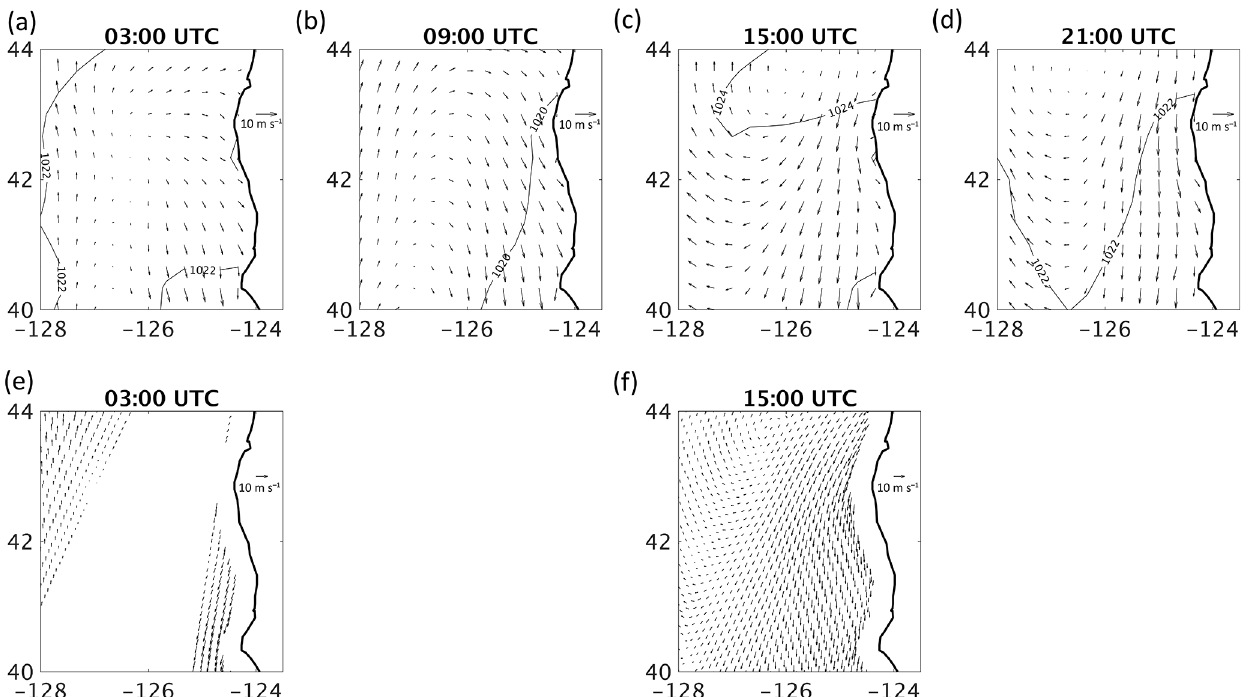
Figure 8. Data stage inputs for the surface wind BHM in the CCS. Analysis fields for surface wind (vectors) and sea-level pressure contours (hPa) from COAMPS for (a) 03:00, (b) 09:00, (c) 15:00, and (d) 21:00UTC. QuikSCAT surface vector wind retrievals from overflights assigned to (e) 03:00UTC and (f) 15:00UTC. The domain shown, 128–124 ◦ W, 40–44 ◦ N, is a small subset of the larger CCS domain of Fig. 1. Data stage inputs from COAMPS and QuikSCAT are for 19 January 2003.